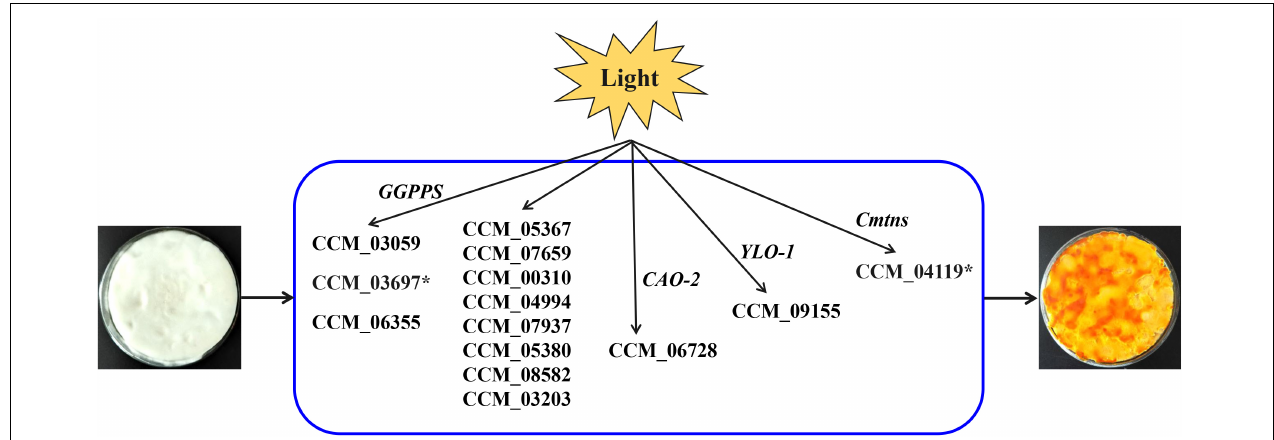
FIGURE 5 | Putative model for light-induced carotenoid formation in C. militaris based on transcriptome analysis and previous studies. ∗ Indicates that the gene is up-regulated in a comparison (CM10_D vs